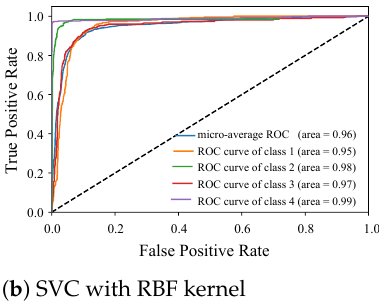
ROC curve of class 3 (area = 0.97) ROC curve of class 4 (area = 0.99)